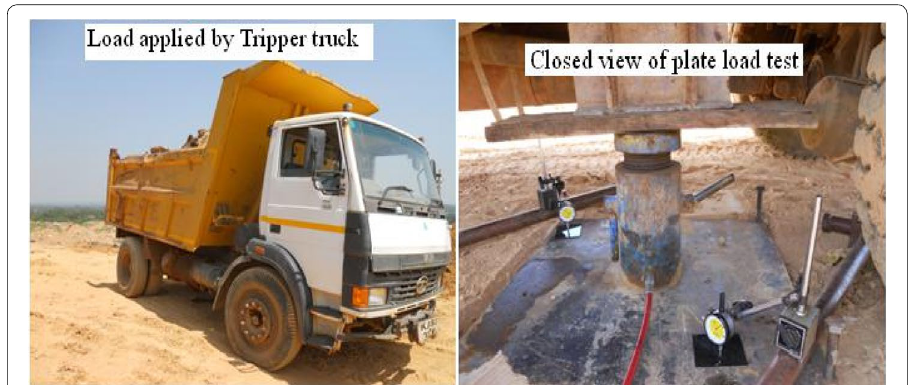
Fig. 15 Typical plate load test setup on the top level of the landfill